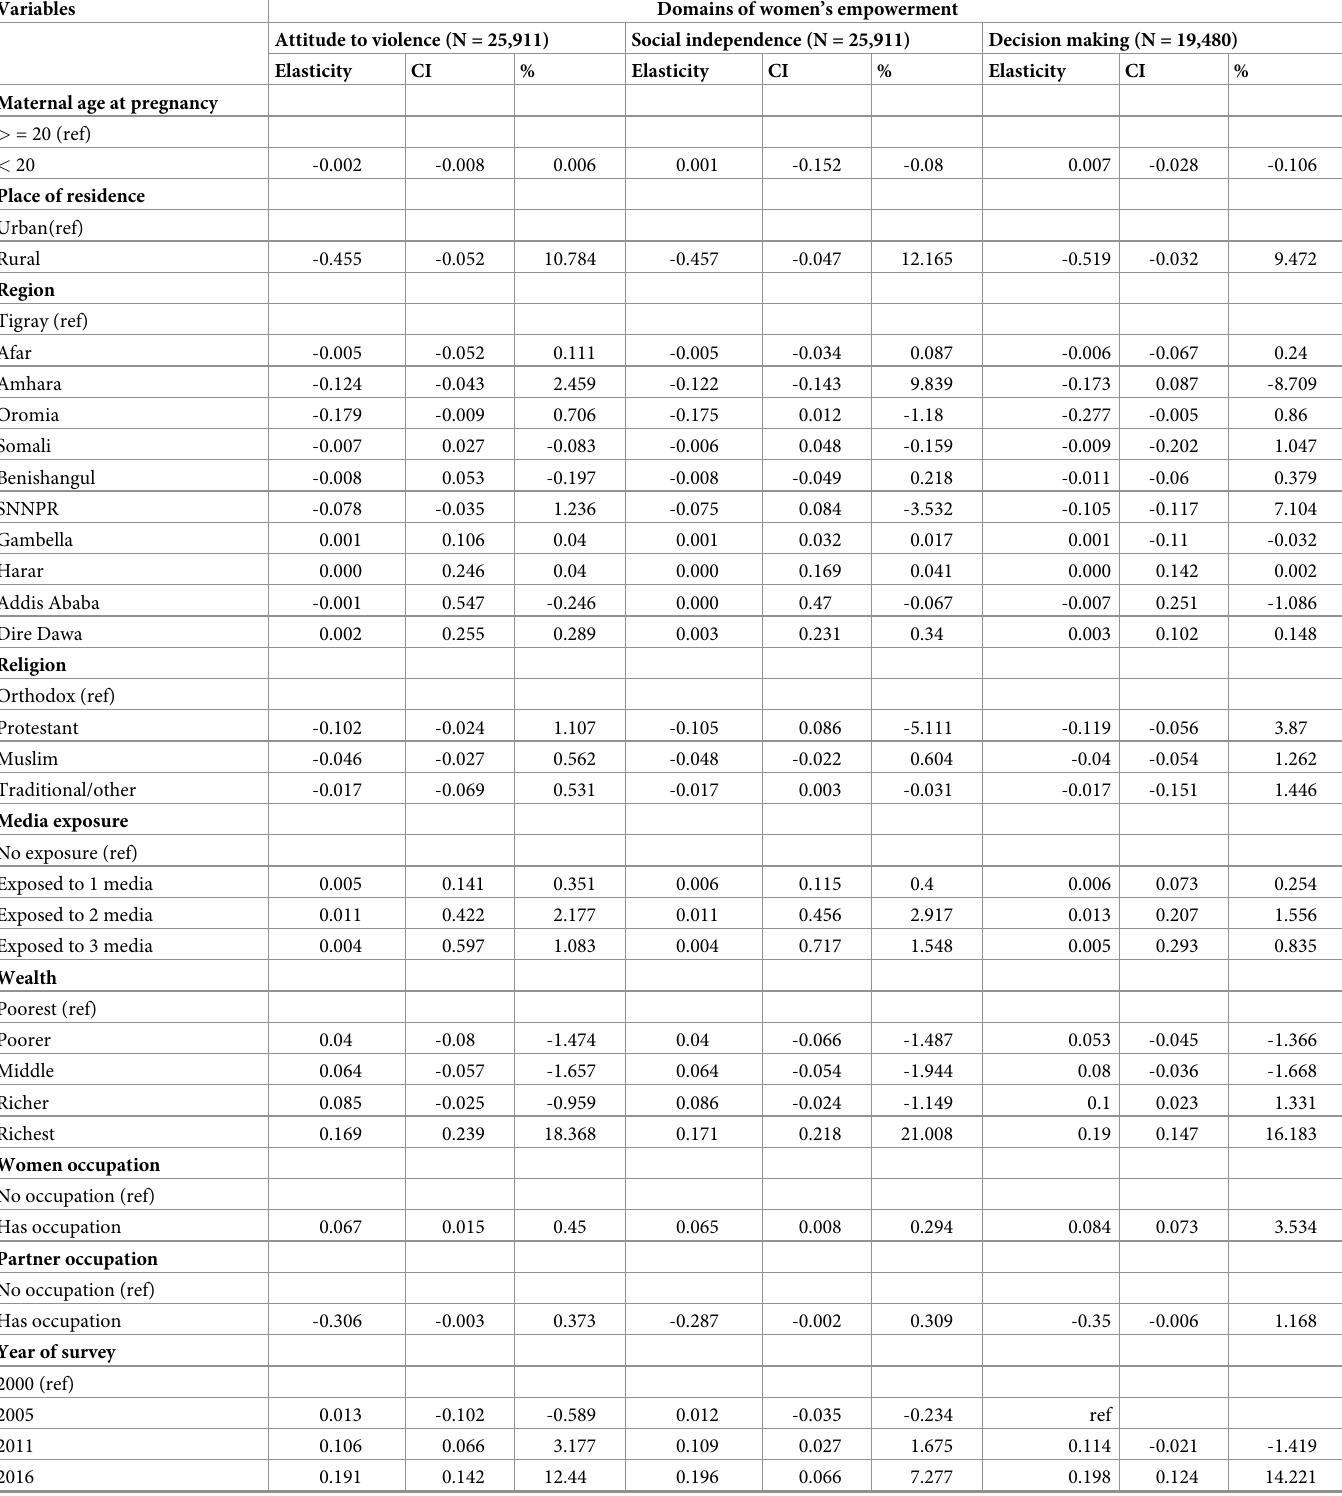
Table 3. Decomposition of the inequalities in the usage of early ANC by women’s empowerment, 2000–2016